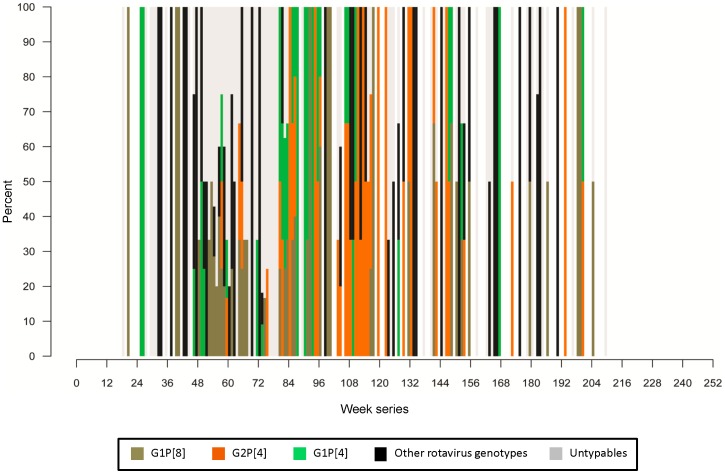
Weekly distribution of different rotavirus genotypes.Observed changes in a relative contribution of rotavirus genotypes indicate temporal clustering characteristic for seasonality in genotype dominance.